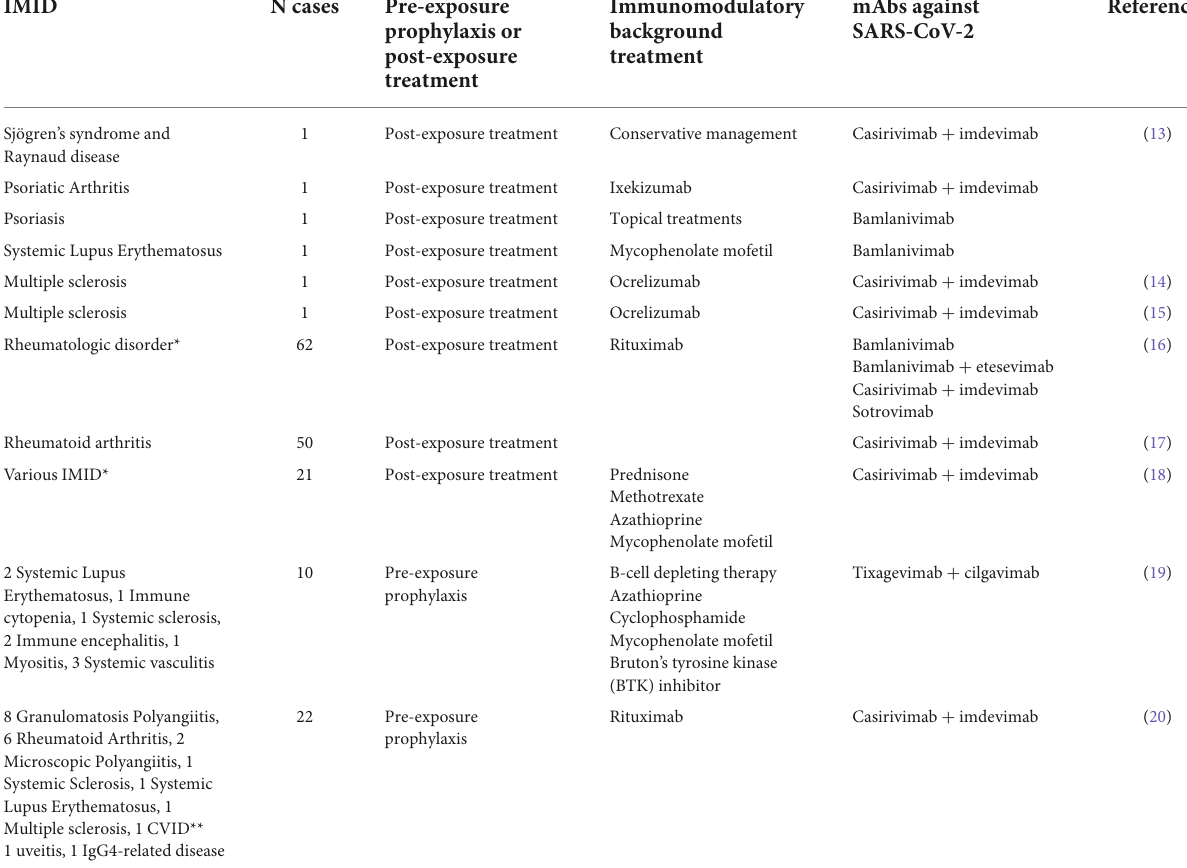
TABLE 2 Overview of current evidence for pre-exposure prophylaxis or post-exposure treatment of mABs in IMID patients. IMID N cases Pre-exposure prophylaxis